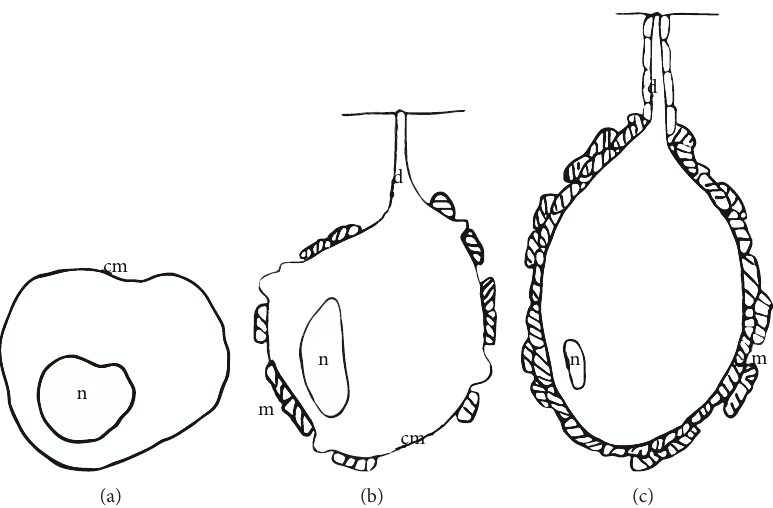
Figure 1: Stages in the development of a vesicle (not to scale). (a) Vesicle cell. (b) Vesicle initial. (c) Vesicle. cm, cell membrane; d, duct; m, muscle; n,